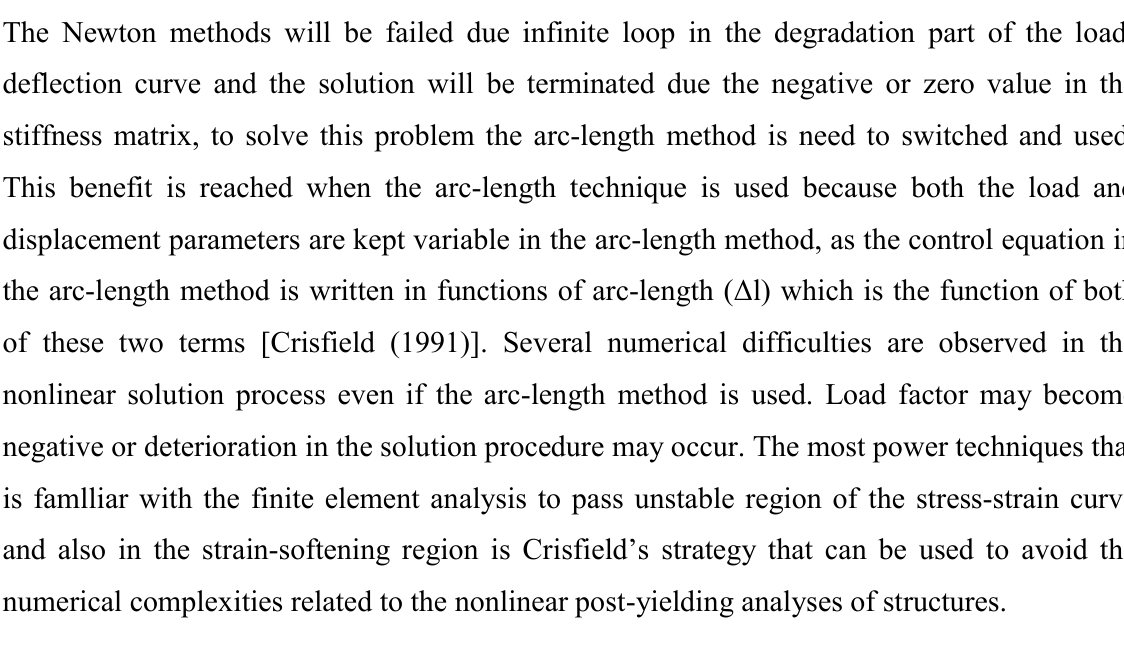
Fig. 1. Typical stress-strain relationship of concrete with unstable and strain-softening